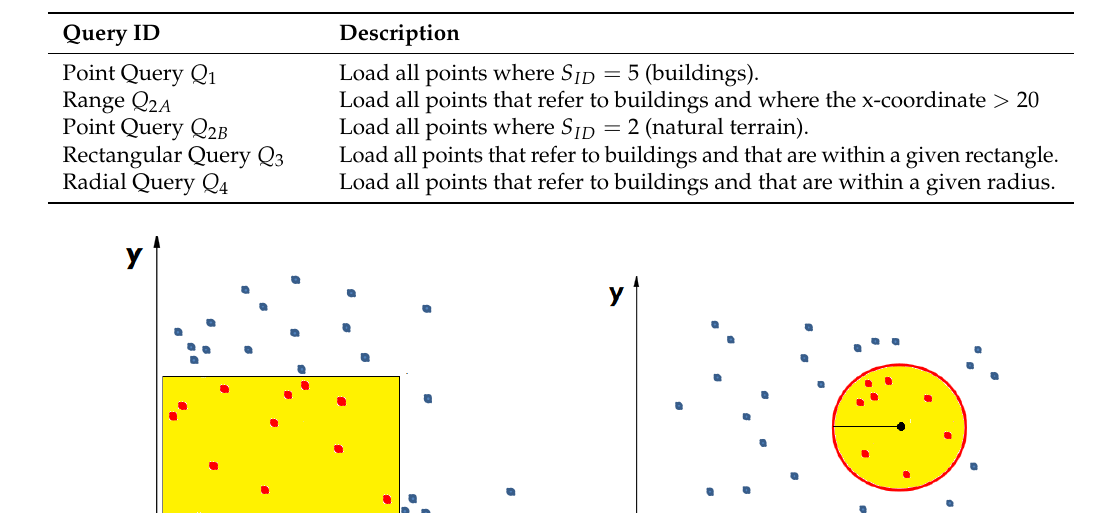
Table 3. The five different queries used for the MEDIUM and LARGE datasets.